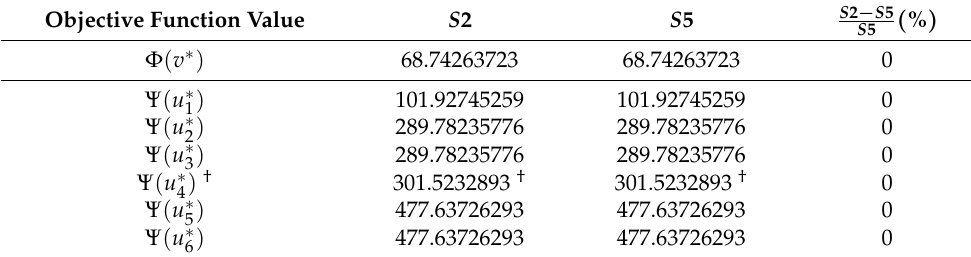
Table 6. Performance analysis: S 2 vs. S 5.